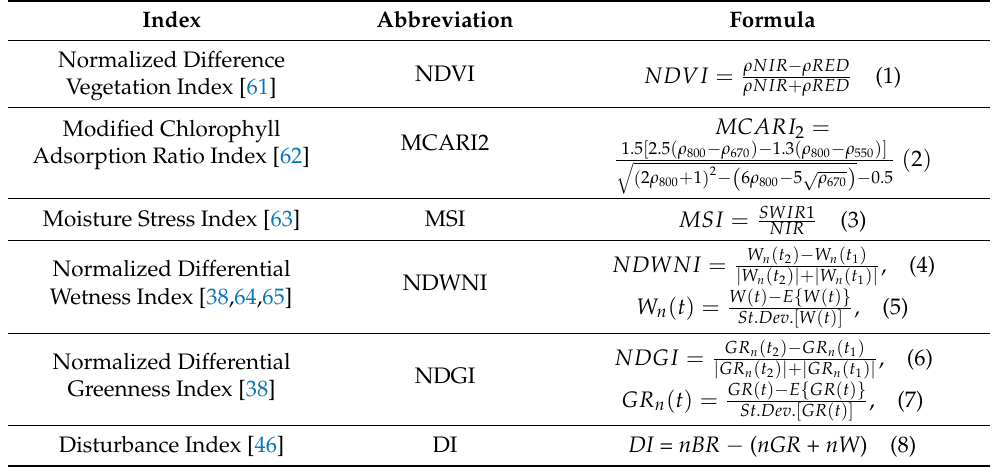
Table 1. Spectral indices calculated in this